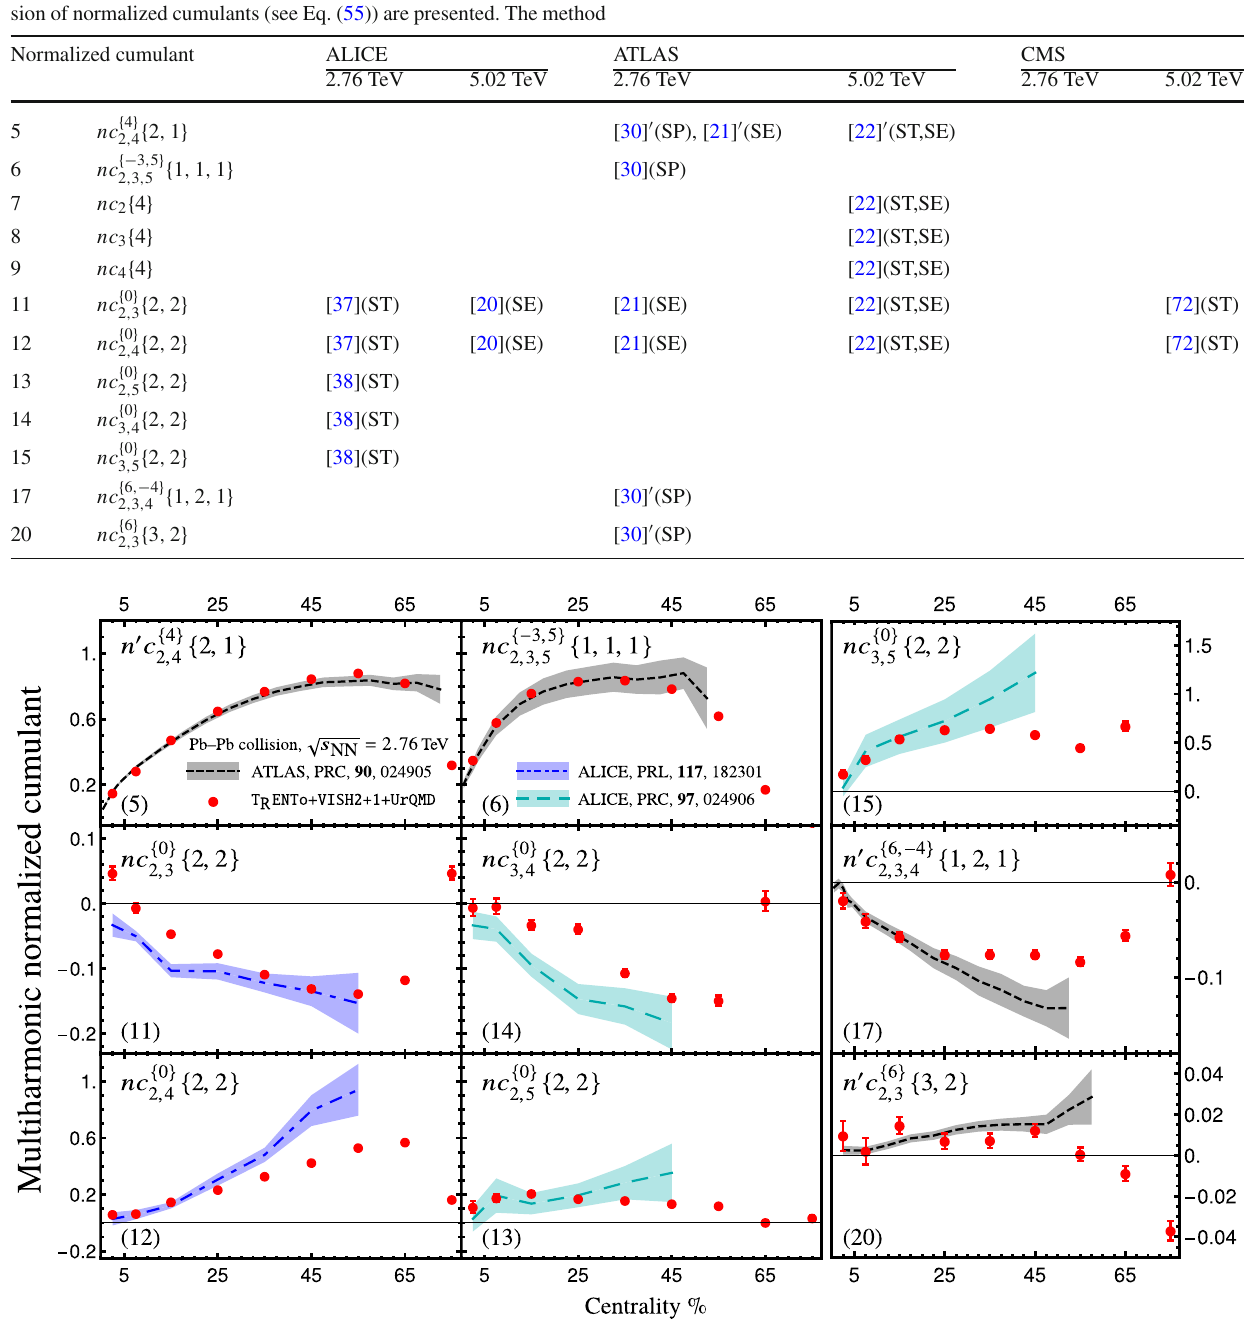
Fig. 2 The (alternative) normalized cumulants that measured by ALICE [37,38] and ATLAS [30] compared with T R ENTo + VISH2+1 +